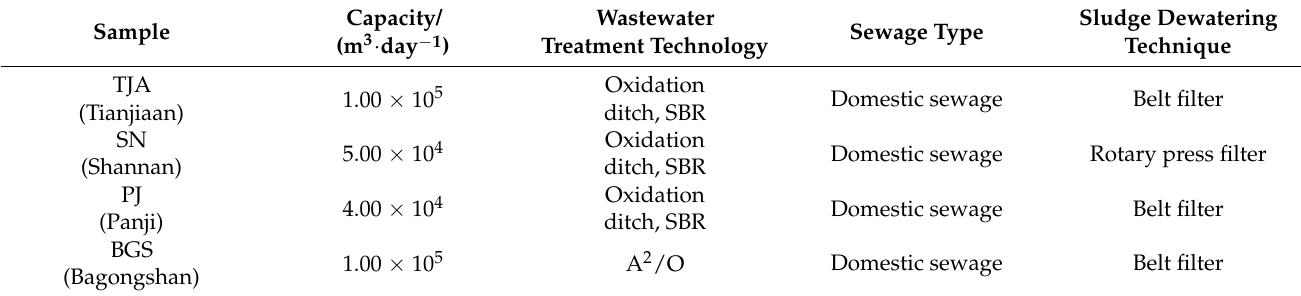
Table 1. Detailed information of the four wastewater treatment